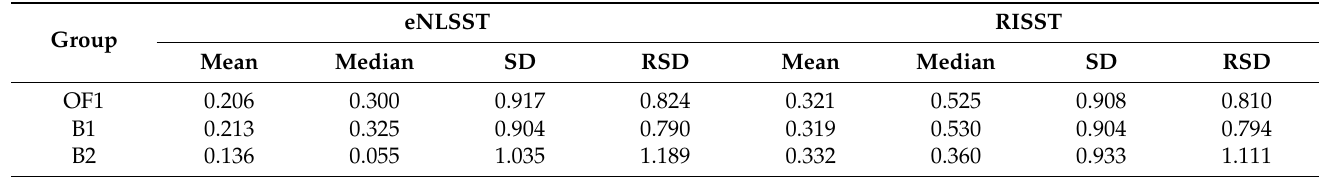
Table 4. Performance of the eNLSST and RISST algorithms with group B1 and